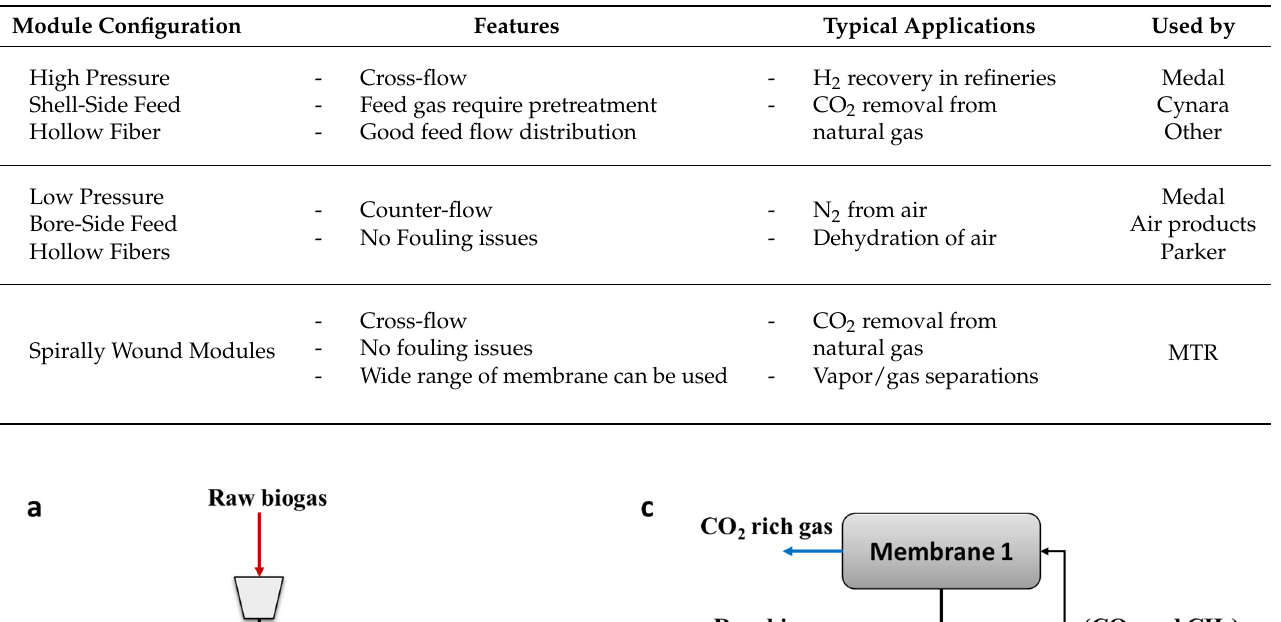
Table 2. Characteristics and typical applications of the different modules for gas separation.